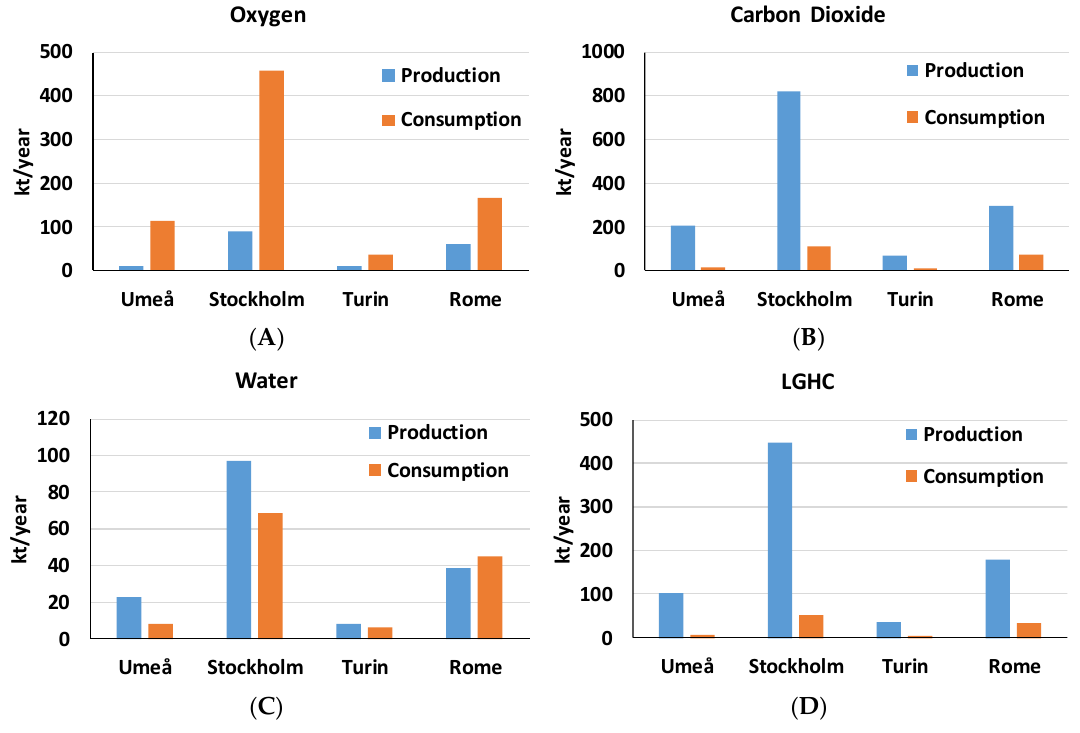
Figure 8. comparison between production and consumption of ( A ) oxygen, ( B ) carbon dioxide, ( C ) water, Figure 8. Comparison between production and consumption of ( A ) oxygen; ( B ) carbon dioxide; ( C ) and ( D ) LGHC in the integrated system water; and ( D ) LGHC in the integrated